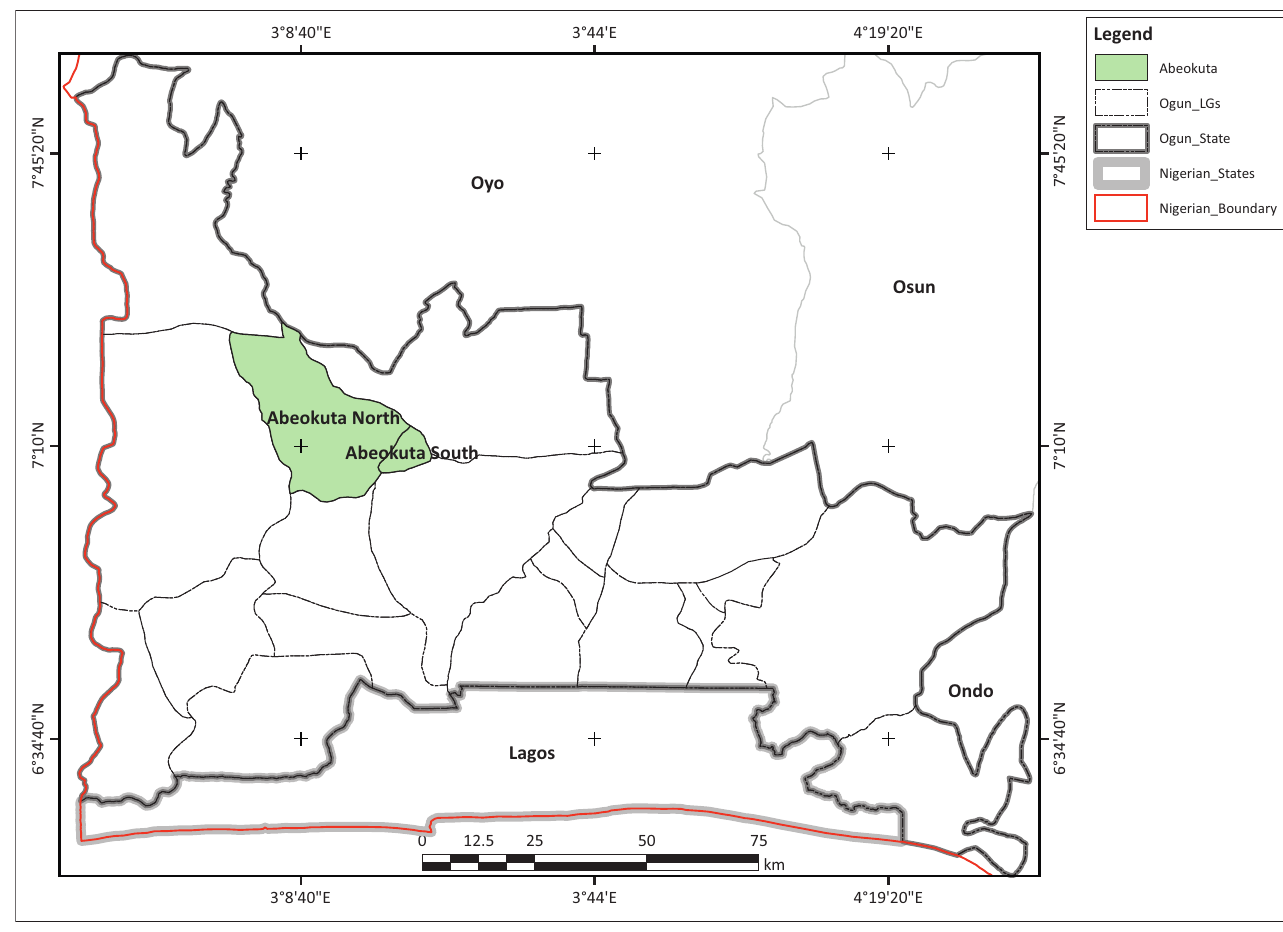
FIGURE 1: Map of Ogun State showing the two local government areas of Abeokuta.